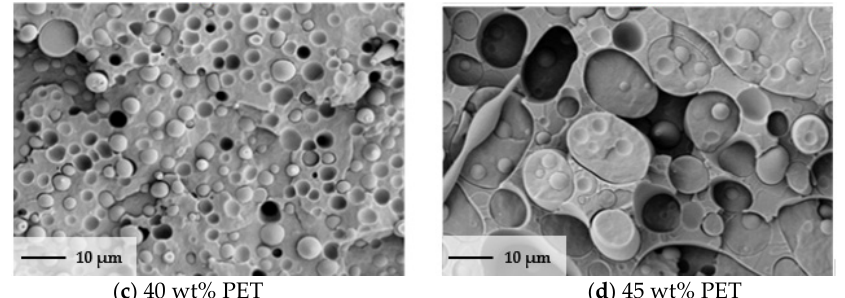
Figure 4. Morphology overview PP/PET of cryo-fractured SEM samples.